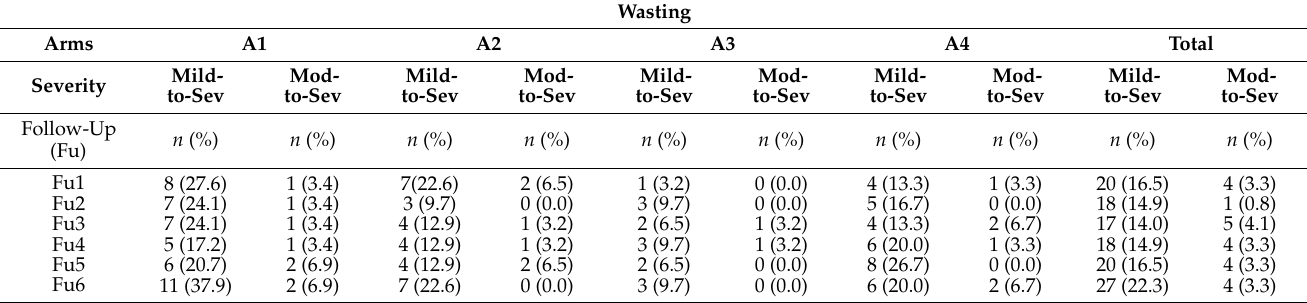
Table 2. The numbers ( n ) and the percentages of children (%) with mild-to-severe (Mild-to-Sev) and moderate-to-severe (Mod-to-Sev) wasting over the follow-up